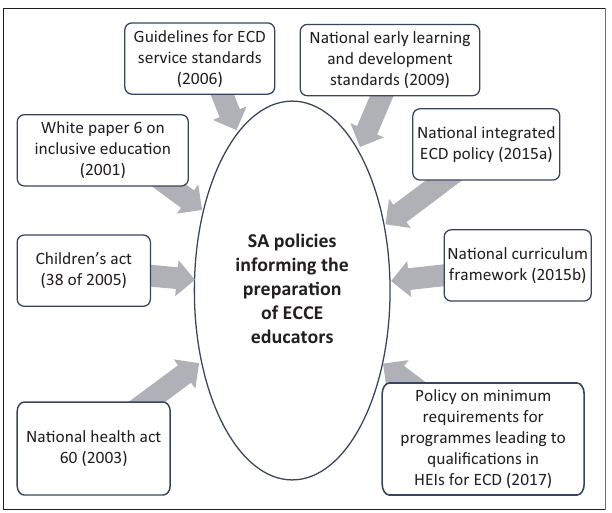
FIGURE 1: South African policies informing preparation of early childhood care and education. ECCE, early childhood care and education; SA, South